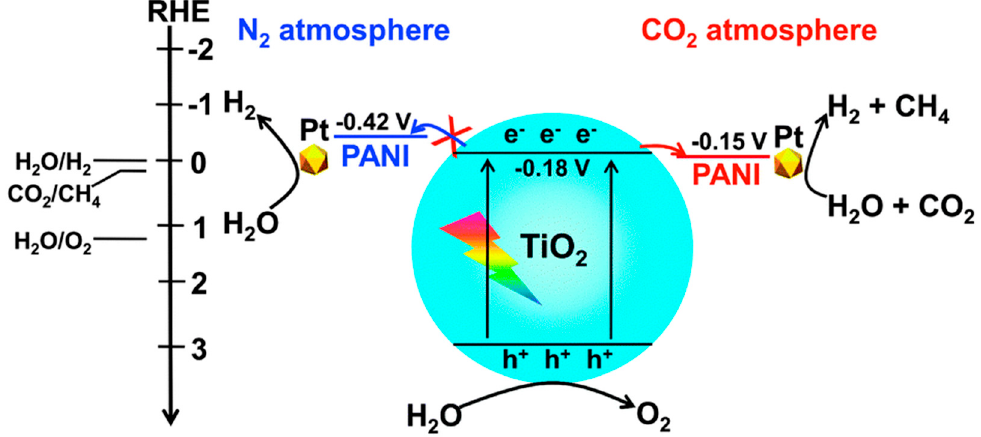
Figure 7. Schematic illustration of the mechanism for CO 2 photoreduction using a binary PANI/TiO 2 composite [99].